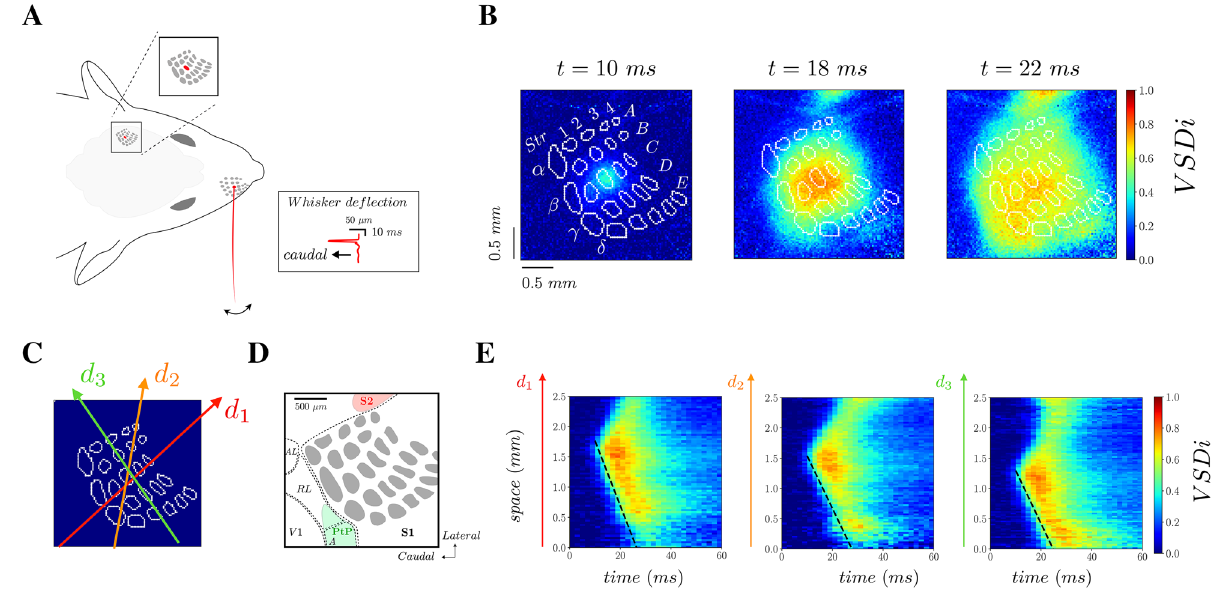
Figure 1. Experimental protocol and anisotropic propagating waves in S1. (A) Experimental setup where the S1 is imaged at 500 images per second while the C2 whisker is stimulated with a piezoelectric actuator (2.7° displacement, with a 2-ms rising ramp, 2-ms plateau, and 2-ms fall). ( B) Color plots show images at different time frames after the beginning of the C2 whisker deflection (t = 0 ms). Intensity of the VSD signal is color- coded and normalized to the maximum intensity in space and time (average of n = 40 trials). The layer 4 barrel map reconstructed from a post hoc cytochrome oxidase staining is shown as overlaid white dots. ( C) The three arrows (d 1 . red, d 2 . orange and d 3 . green) indicate different spatial directions that we employ for a spatio- temporal visualization of VSD activity (linescan plots on panel E ). We have estimated, in each direction, the velocity of propagation through a fitting procedure based on the rise of activity in time at each spatial location. The fits (v c = 0.1 + /− 0.01 m/s for the three directions) are reported as dashed black lines on the plots. ( D) Typical field of view covering the whiskers representation area within S1 (barrels are shown in grey), with the approximated locations of the secondary somatosensory area (S2, as reported from 20 ) and the posterior part of the parietal cortex (PtP), as reported from 21 ( V1 primary visual area, AL anterolateral area, RL rostrolateral area, A anterior area). ( D) Linescan plots in the directions shown in panel ( C)